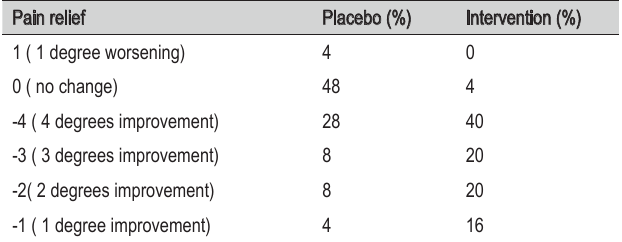
Table 2 - Comparison of pain relief between the two groups